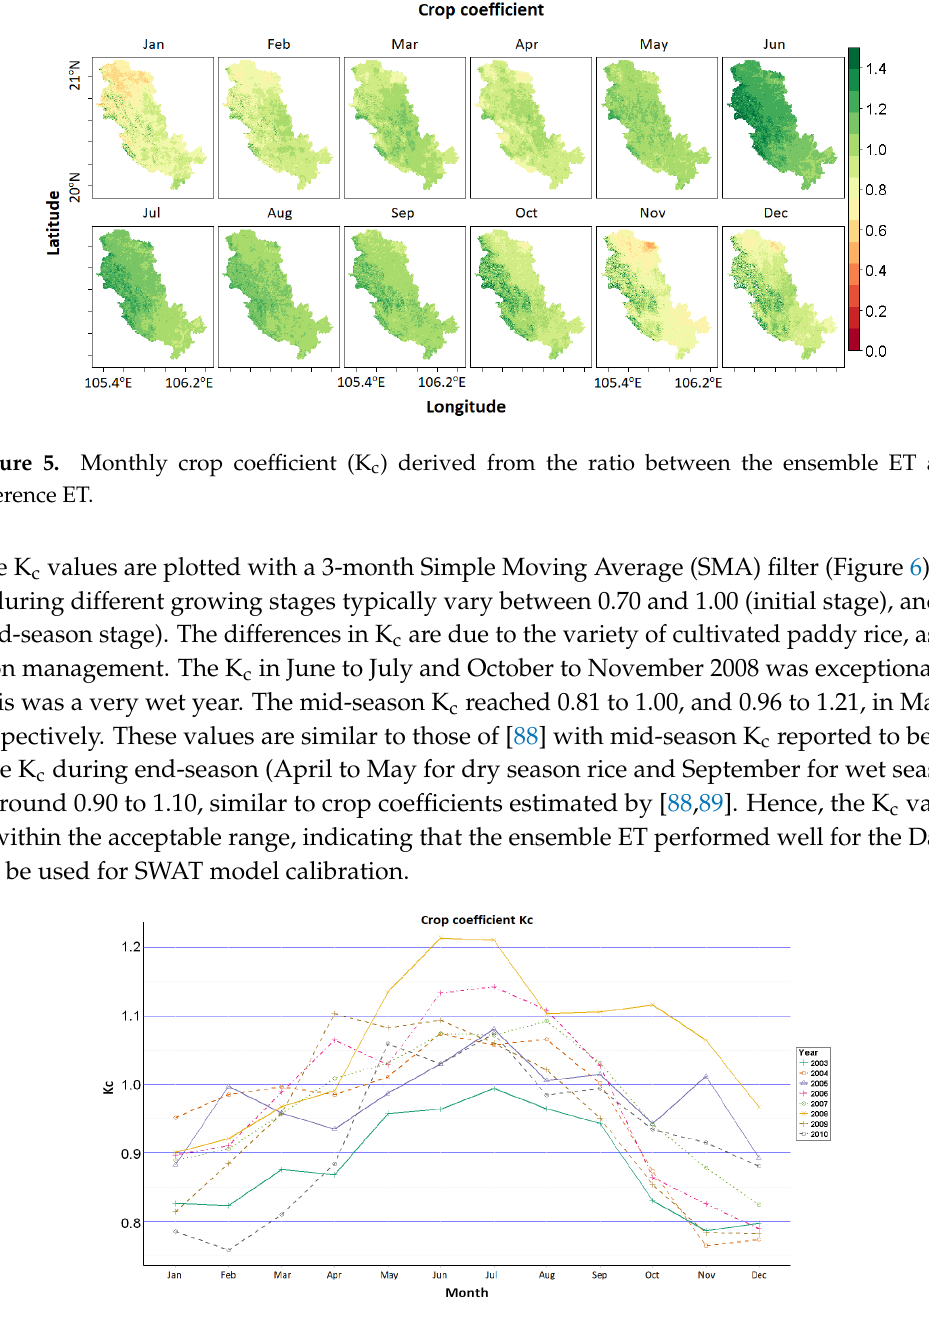
Figure 6. Simple Moving Average (SMA) for crop coefficient (K c ) for paddy rice in the Day Basin.